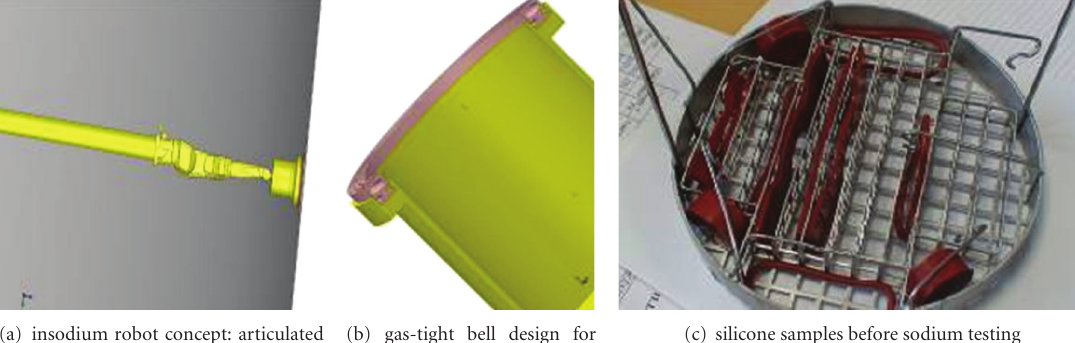
(b) gas-tight bell design for Repair tools Figure 26: Tools for insodium intervention.